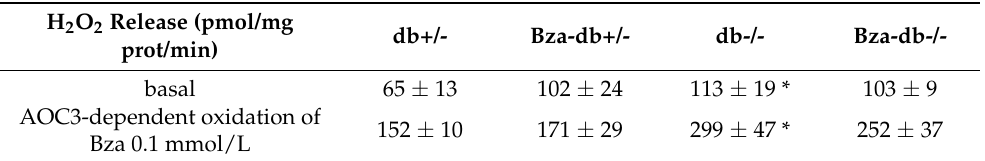
Table 5. Hydrogen peroxide release in SCWAT homogenates from mice subjected or not to benzy- lamine